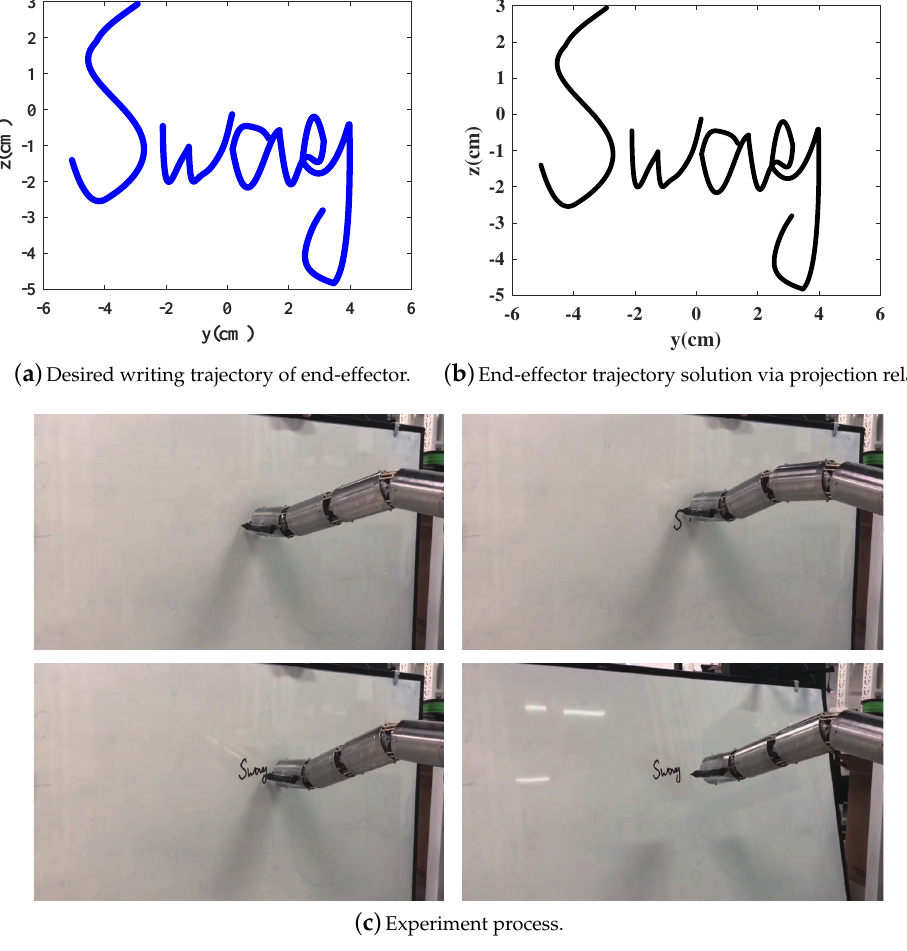
Figure 7. End-effector trajectory and experiment process of writing on a white